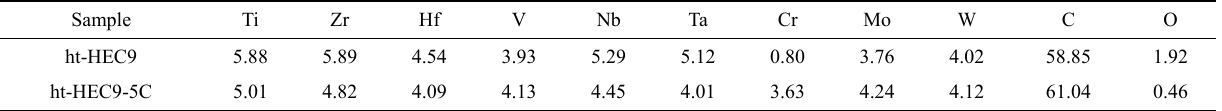
Table 3 Atomic percentages of the elements in the ht-HEC9 and ht-HEC9-5C by the EDS analysis (Unit: at%) Sample